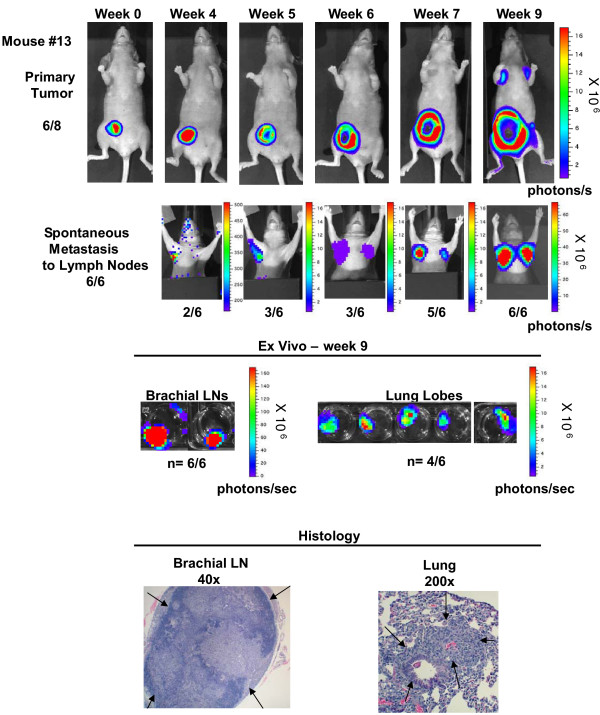
D3H2LN mammary tumors grow rapidly and produce bilateral lymph node metastasis. Bioluminescent D3H2LN cells were injected into nude-beige mice, and tumor growth and metastasis were monitored over time in vivo. Data for a representative mouse are shown. Tumor take rate was high (6/8 mice) and lymph node metastasis to both the right and left thoracic areas was detected by week 9 in all mice with mammary tumors (upper panels). Ex vivo images of excised brachial lymph nodes and lung lobes are shown (middle panels). Histological analysis of the same tissues confirmed perfuse metastasis to the lymph nodes and isolated micrometastasis to the lung lobes (lower panels).